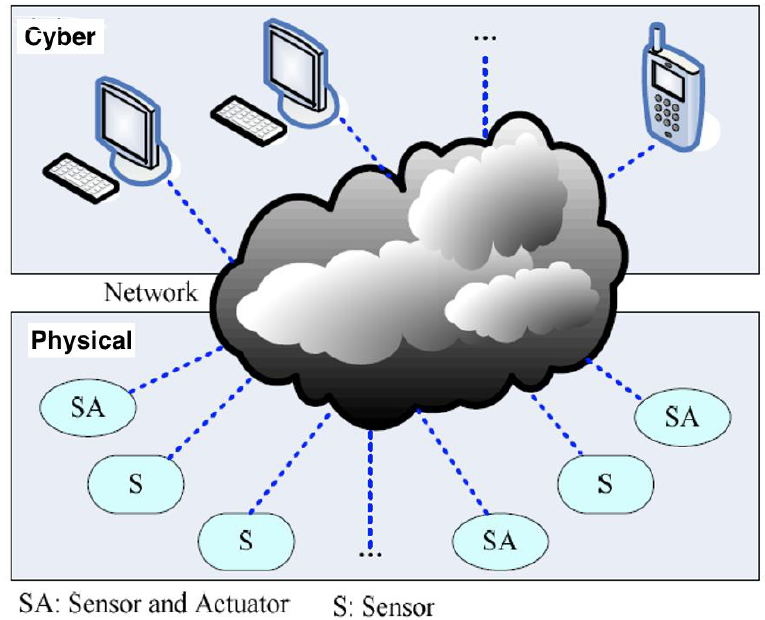
Figure 1. Diagrammatic layout for CPSs.